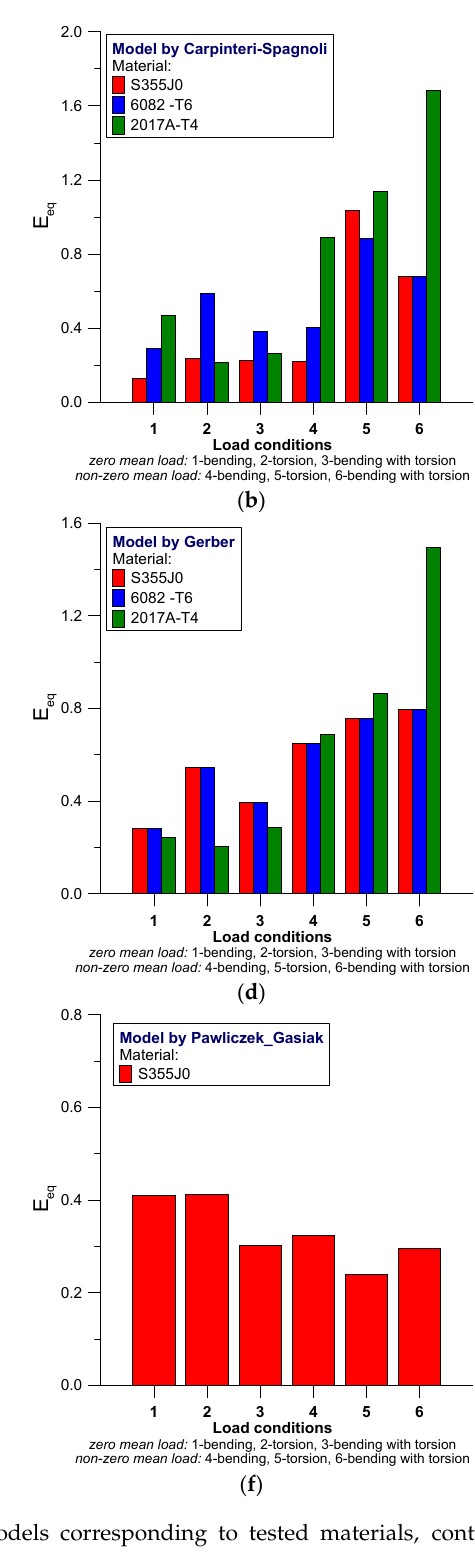
Figure 4. Scatter bands E eq for the analyzed models corresponding to tested materials. ( a ) Kluger- Lagoda; ( b ) Matake; ( c ) Findley; ( d ) Dang Van; ( e ) Papadopoulos; ( f ) Smith-Watson-Topper.